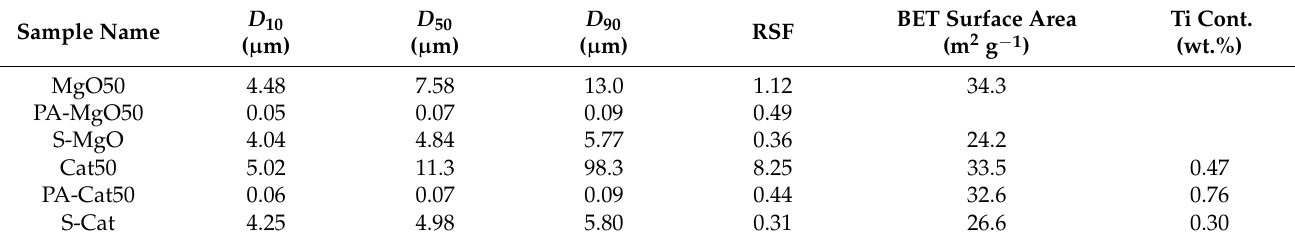
Figure 3. Particle size distribution of the three supports before and after TiCl 4 treatment, measured by light scattering experiment using n -heptane as the dispersant. Table 1. Summary of the particle size analysis of the support and catalyst samples.